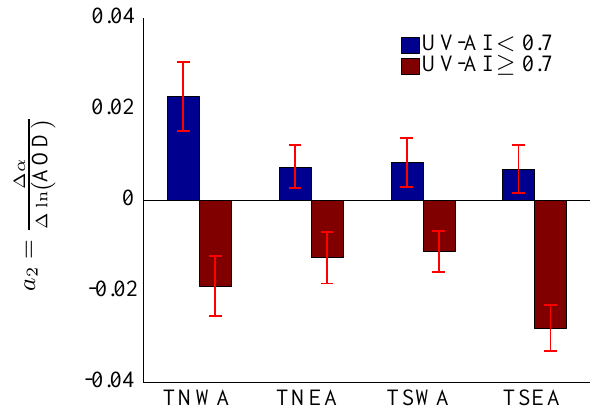
Fig. 2. Result from the regressions analysis: coefficients a 2 in Eq. (1) and respective standard deviations for the selected Fig. 2: Result from the regressions analysis: coefficients a 2 in Eq.1 and respective standard deviations for the selected regions.